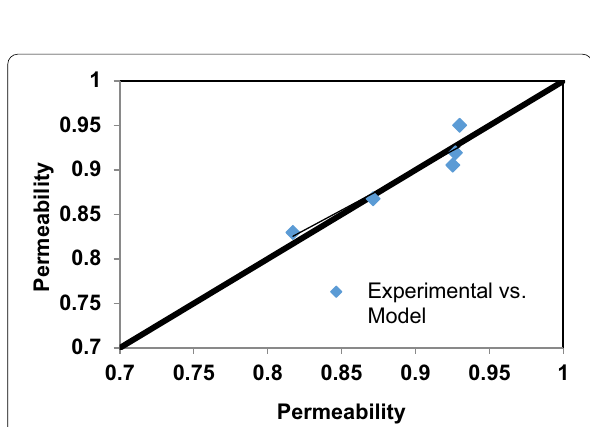
Fig. 3 Comparison between experimental data and model predicted (9) percentage as a function of time, flux, and permeability, respectively. The comparison shows a good fit between experimental results and modeling results, which indicate that the model can be used to predict the performance